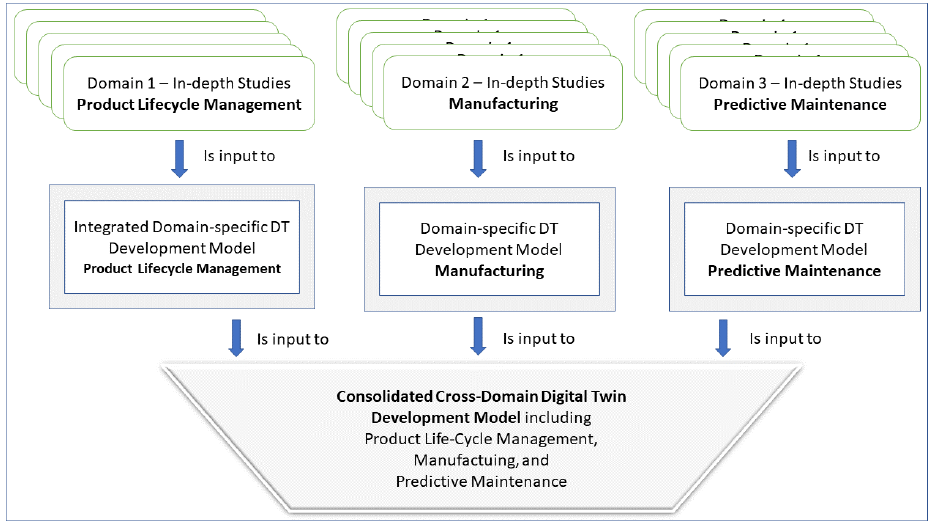
Figure 3. Model development process based on selected in-depth studies.